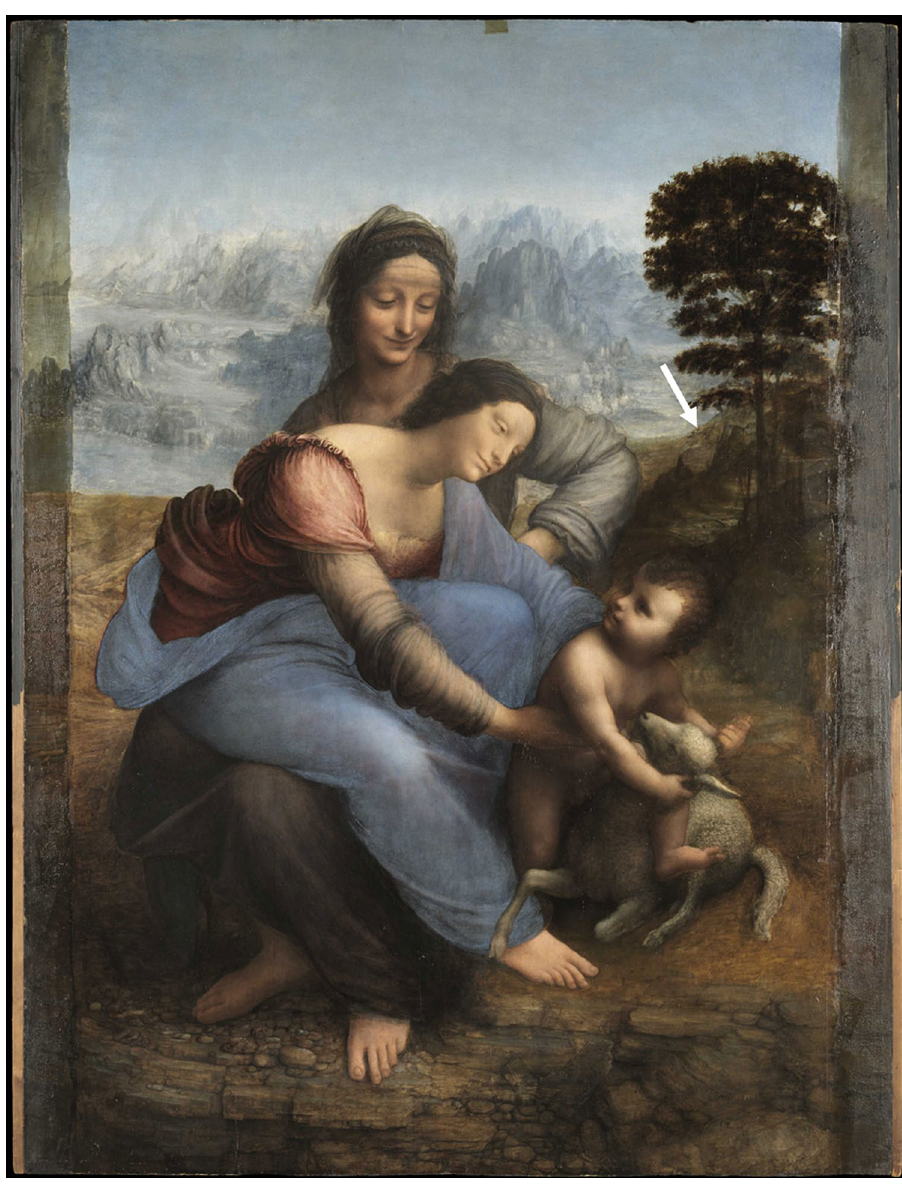
Figure 1. Leonardo da Vinci, The Virgin and Child with St. Anne , (168 × 130 cm), 1503–1519, Musée du Louvre. Image courtesy of C2RMF. The white arrow indicates the location of